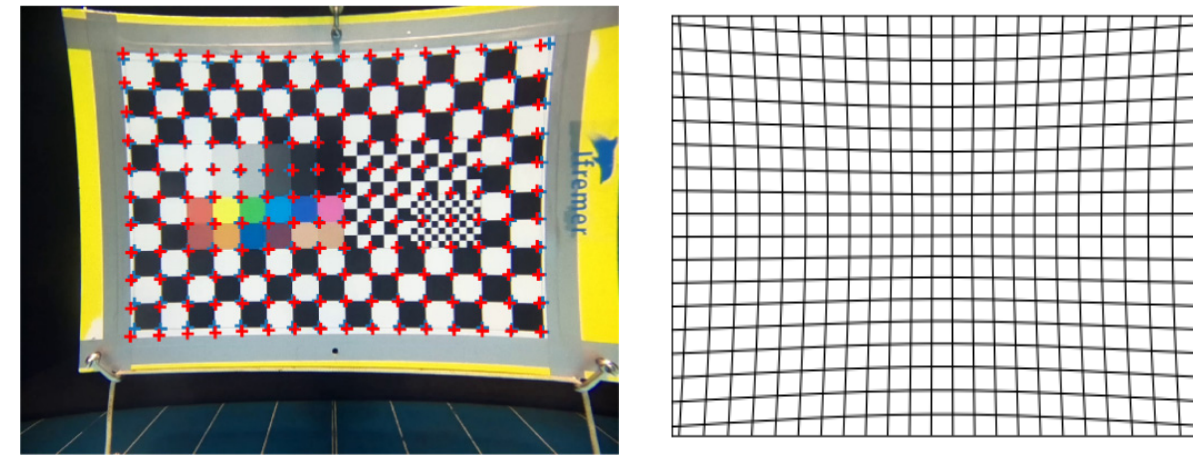
Figure 9. KOSMOS image of the pattern test at 1 m distance. The superimposed blue crosses are the observed nodes of the